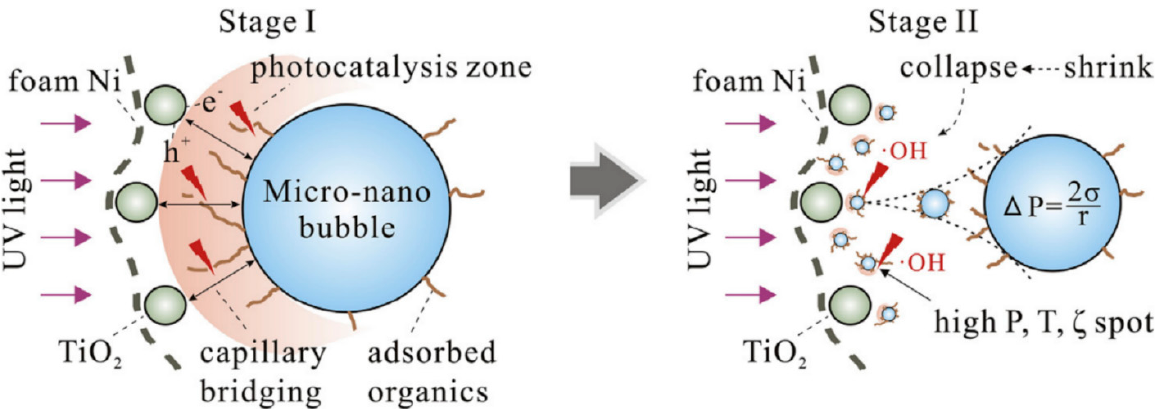
Figure 3. Two stages of purification in the MNB-UV/TiO 2 hybrid system. P is the pressure, T is the temperature, ζ is the electric potential, Δ P is the Laplace pressure, σ is the surface tension and r is the bubble radius [106] (“foam Ni” is a base material for TiO 2 attachment). Reprinted with permission from Ref. [106].